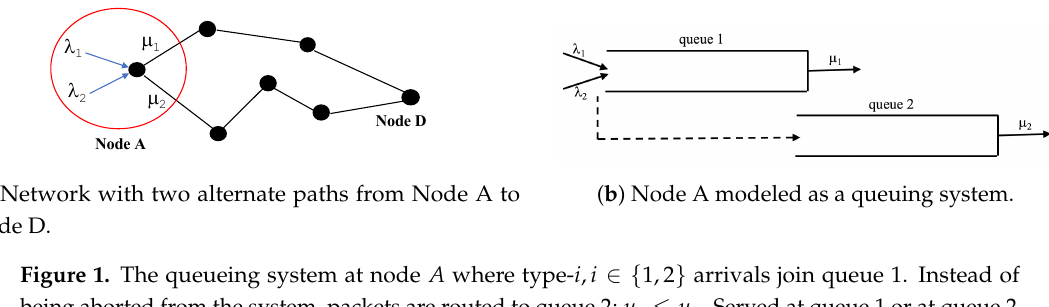
Figure 1. The queueing system at node A where type- i , i ∈ { 1,2 } arrivals join queue 1. Instead of being aborted from the system, packets are routed to queue 2; µ 2 ≤ µ 1 . Served at queue 1 or at queue 2, packets will reach the same destination D over alternate paths